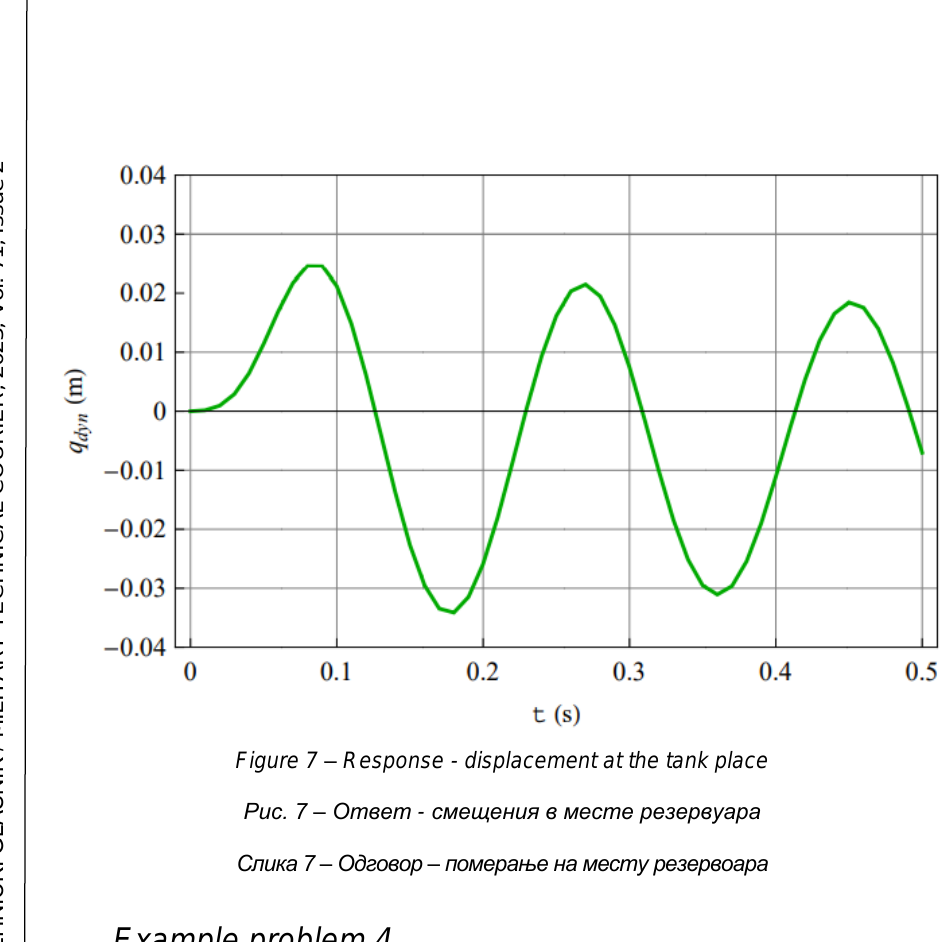
Figure 7 – Response - displacement at the tank place Рис. 7 – Ответ - смещения в месте